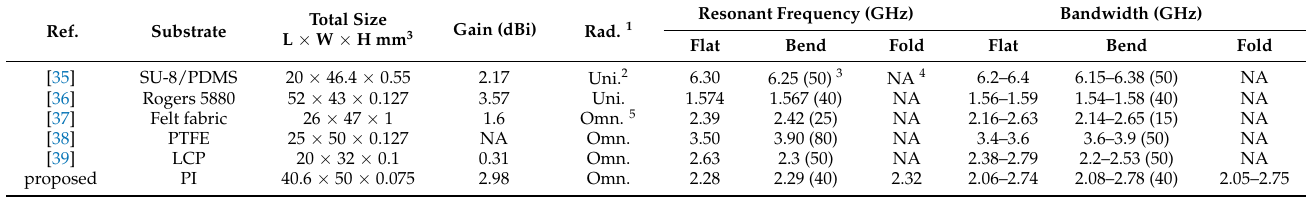
Table 6. Comparison of flexible antennas fabricated on different